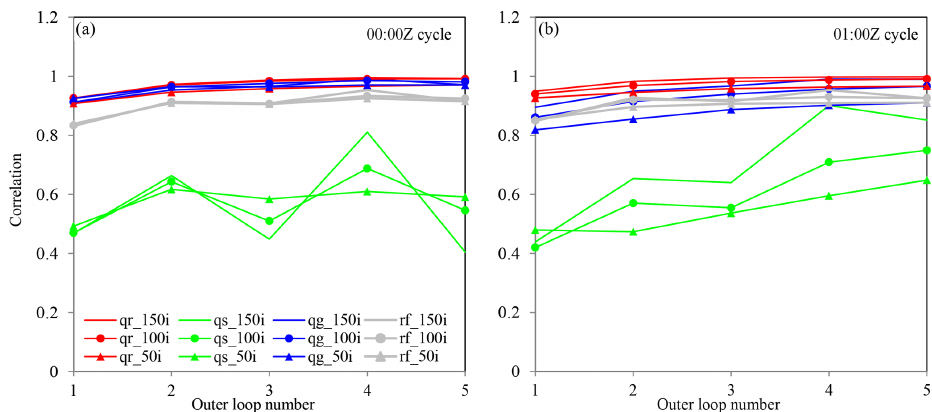
Figure 10. The correlation coefficients of q r (red), q s (green), q g (blue), and reflectivity (gray) between the Exp_ref analysis (with six outer loops and 150 inner iterations each loop) and that with different numbers of outer loops and inner iterations at (a) 00:00Z and (b) 01:00Z.